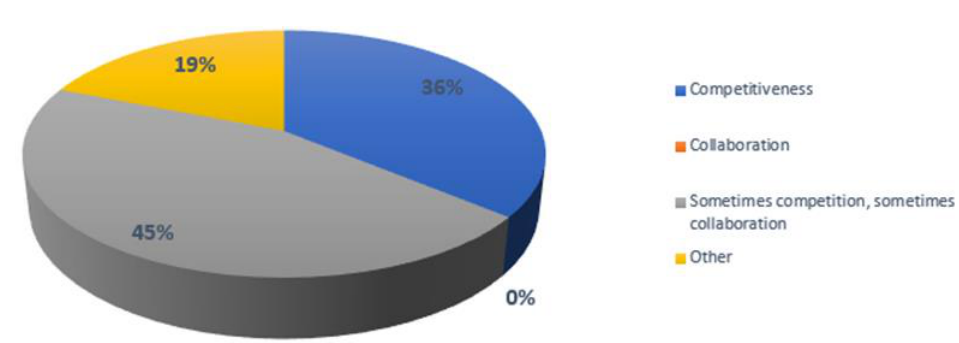
Figure 2. LDAs—Local Government Coexistence. Source: Research data 2019-authors. Figure 2. LDAs — Local Government Coexistence. Source: Research data 2019-authors.